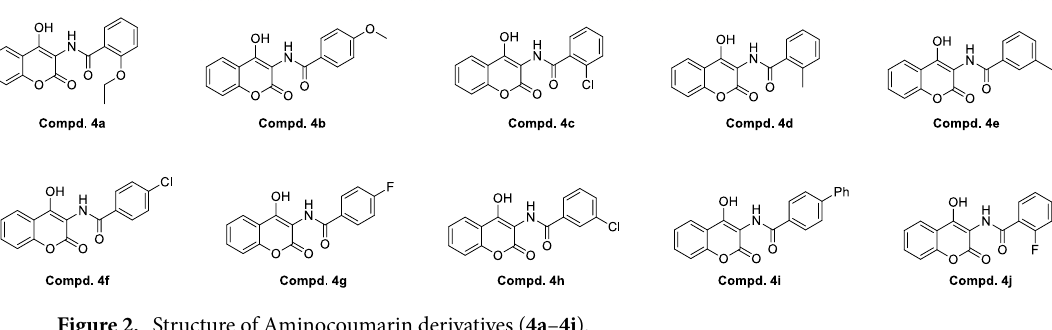
Figure 2. Structure of Aminocoumarin derivatives ( 4a – 4j